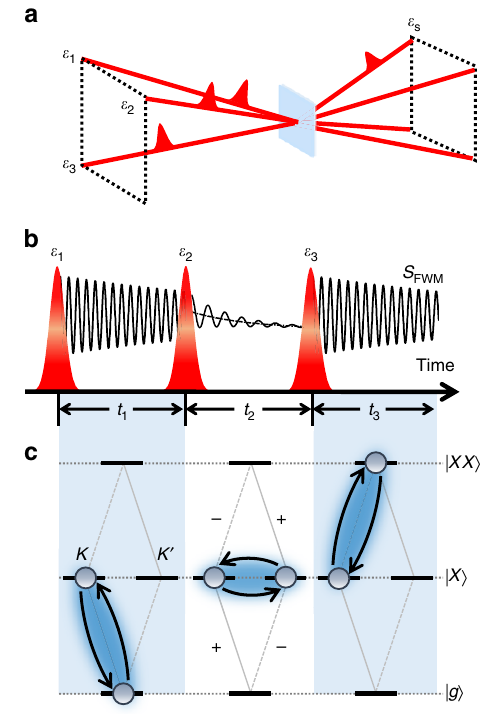
Figure 2 | Illustration of 2DCS of biexcitons. ( a ) Box geometry used for the 2DCS experiments. Three pulses interact nonlinearly with the sample to generate a four-wave mixing signal that is collected in transmission and detected through heterodyne spectral interferometry. ( b ) Time ordering of the excitation pulses and detected signal. ( c ) The quantum pathway for